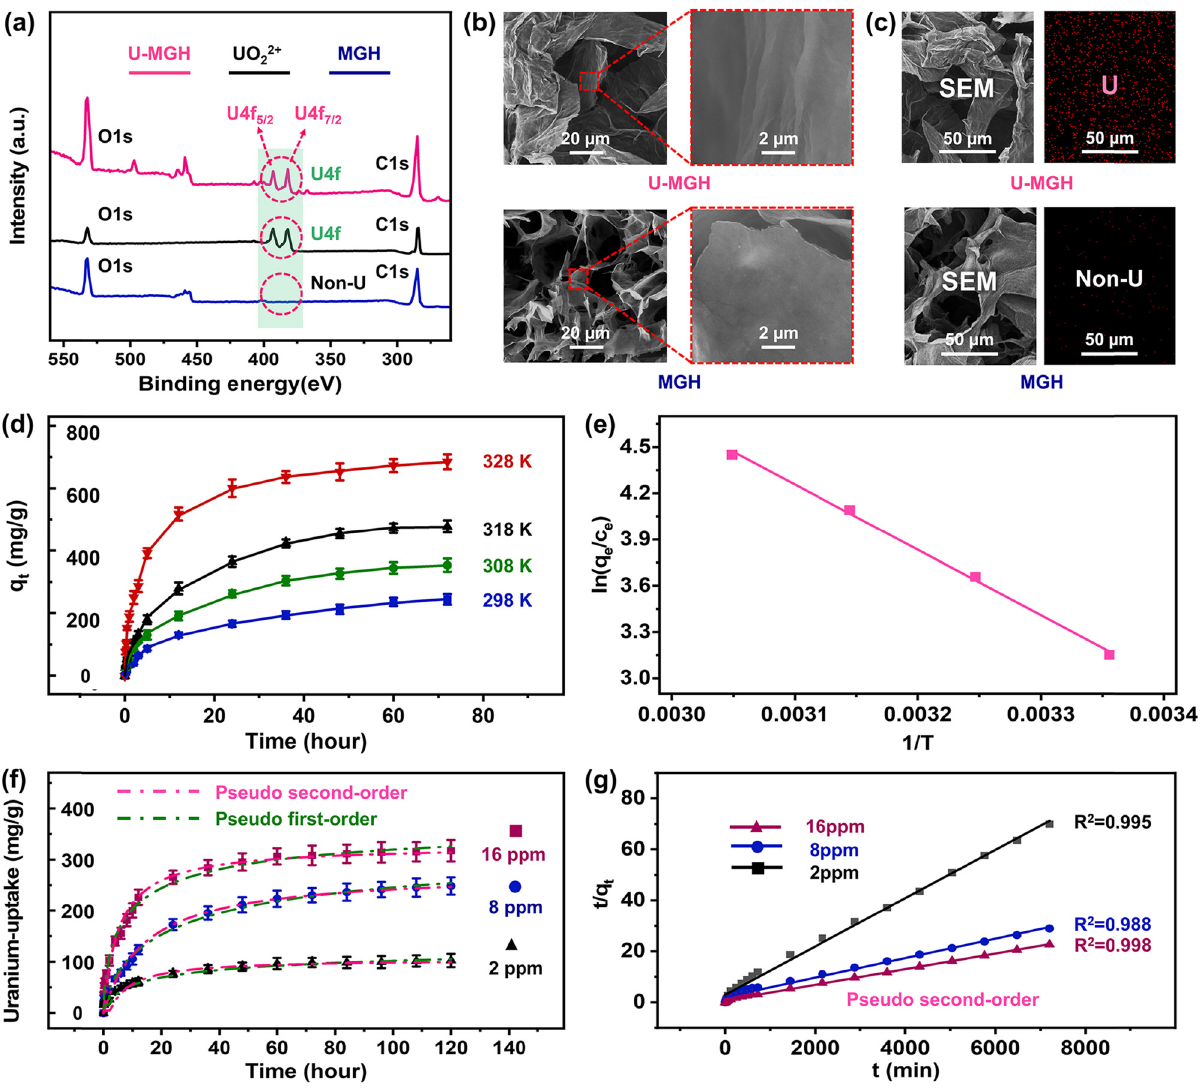
Figure 3: Comparison of ( a ) XPS spectra, ( b ) SEM images, and ( c ) U - element EDS mappings between the original MGH and U - MGH. ( d ) U - adsorbing kinetics and ( e ) thermodynamics on ln ( q ( pH = 6 ) . ( f ) U - adsorbing kinetics of the MGH and ( g ) subsequent analysis via pseudo - second - order equation within U - spiked simulated seawater ( pH = 6 )